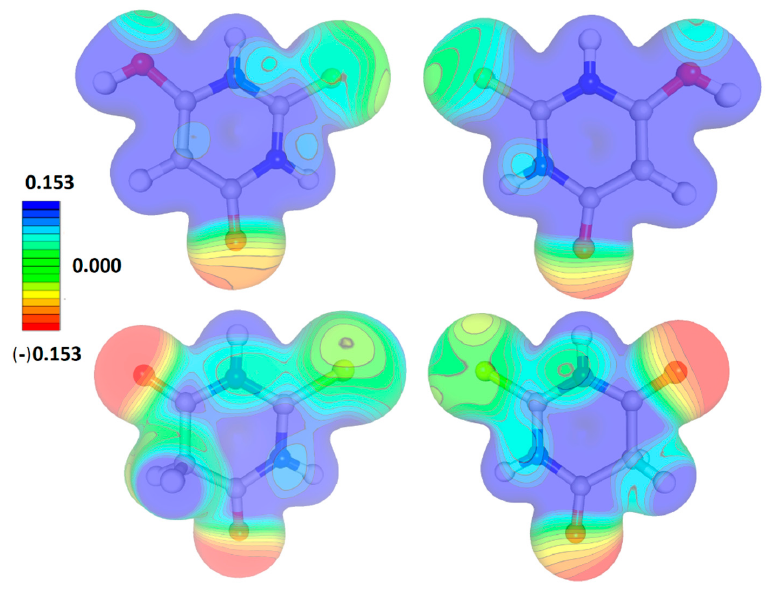
Figure 4. The electrostatic potential of TBA tautomers as seen from both sides of the appropriate molecular planes.